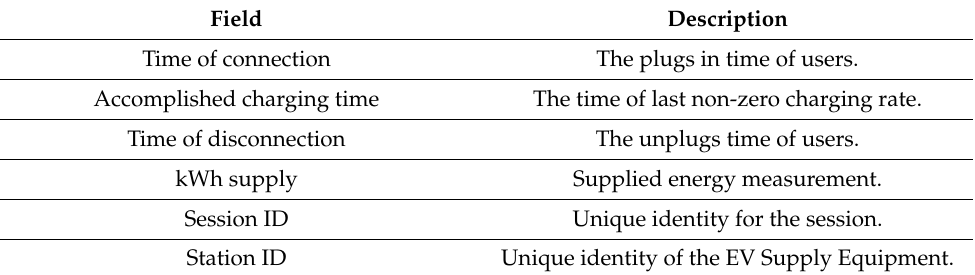
Table 3. Data fields in